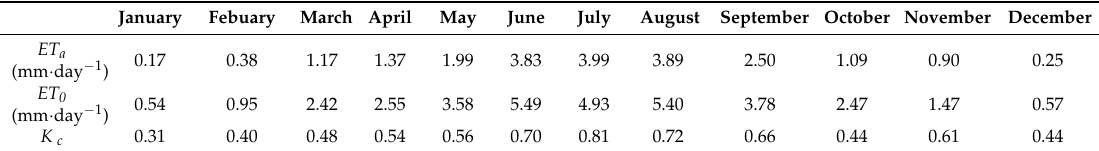
Table 6. Monthly averages of the actual evapotranspiration ( ET a ), reference evapotranspiration ( ET 0 ) and crop coefficient ( K c ) at the Yingke site in 2008.